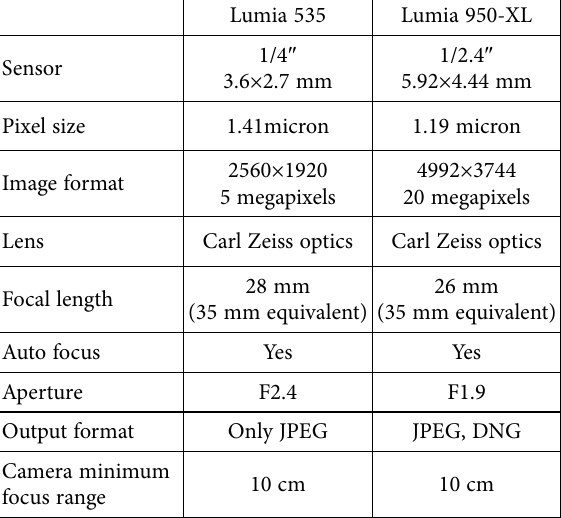
Table 1. Specifications of the used digital